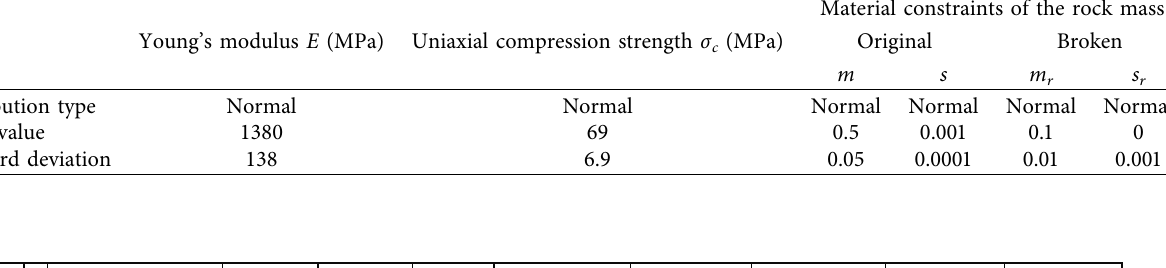
Table 2: Statistical parameters of the random variables in example 2.